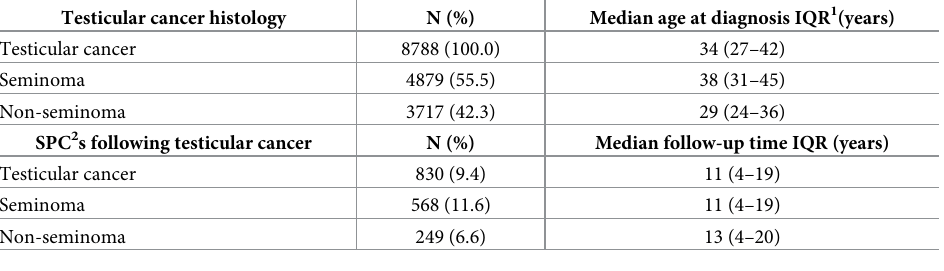
Table 1. The number and age at diagnosis of patients with testicular cancer and number of patients with second primary